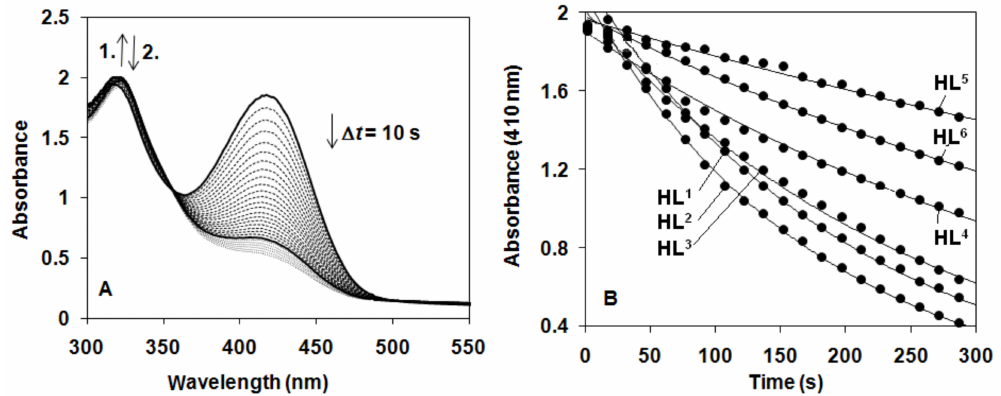
Figure 7. ( A ) Time-dependent UV–vis spectra of a 0.16 mM solution of morin at pH 10 in the presence of 10 mM H 2 O 2 and 1.6 µ M [Mn II (HL 1 )Cl 2 ] ( 1 ) at 25 ◦ C. ( B ) Typical kinetic traces of morin